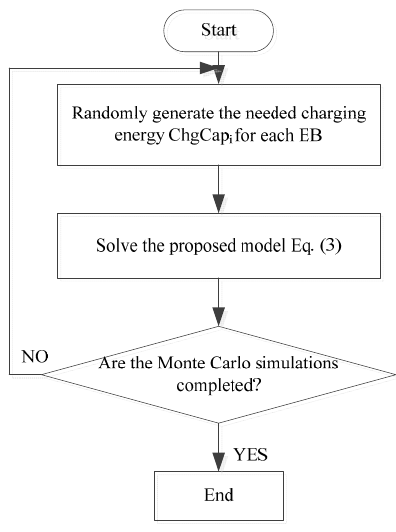
Figure 5. Flow diagram of the proposed stochastic simulation.